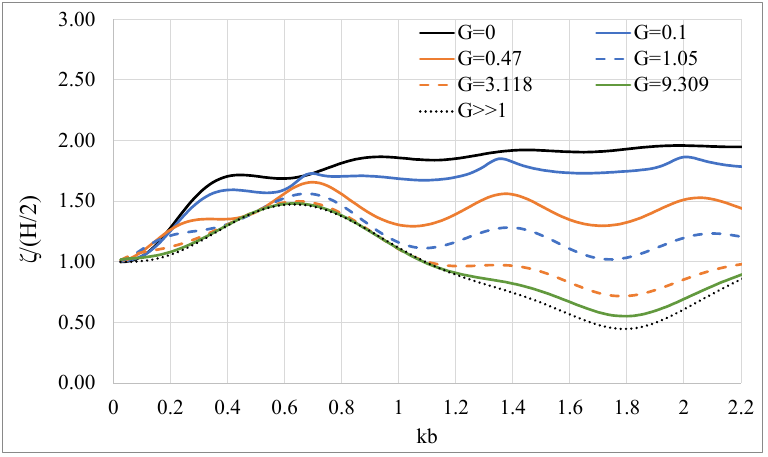
cylindrical body. The results are compared against those reported in [62].